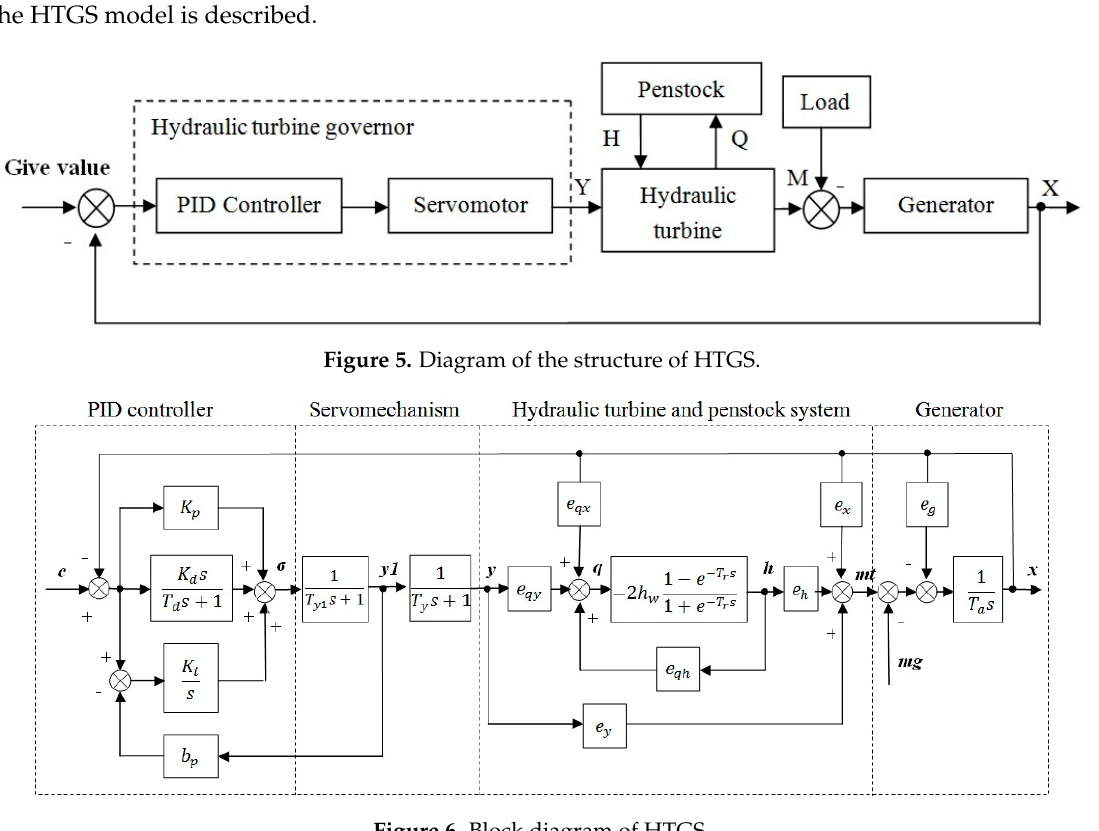
Figure 6. Block diagram of HTGS.